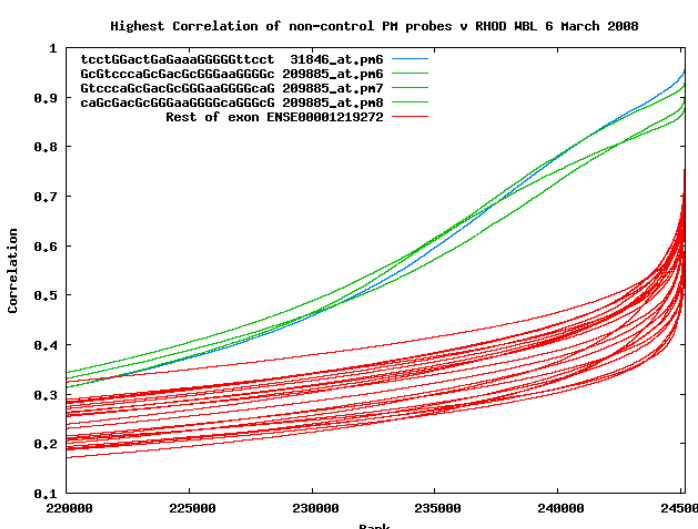
Figure 14: Rank of correlations between each of the probes mapping to exon ENSE00001219272 and the rest of the probes on the GeneChip HG-U133Av2. The several thousand probes that show close correlation have runs of contiguous guanines. We suggest this signal comes from probe-probe interactions resulting in